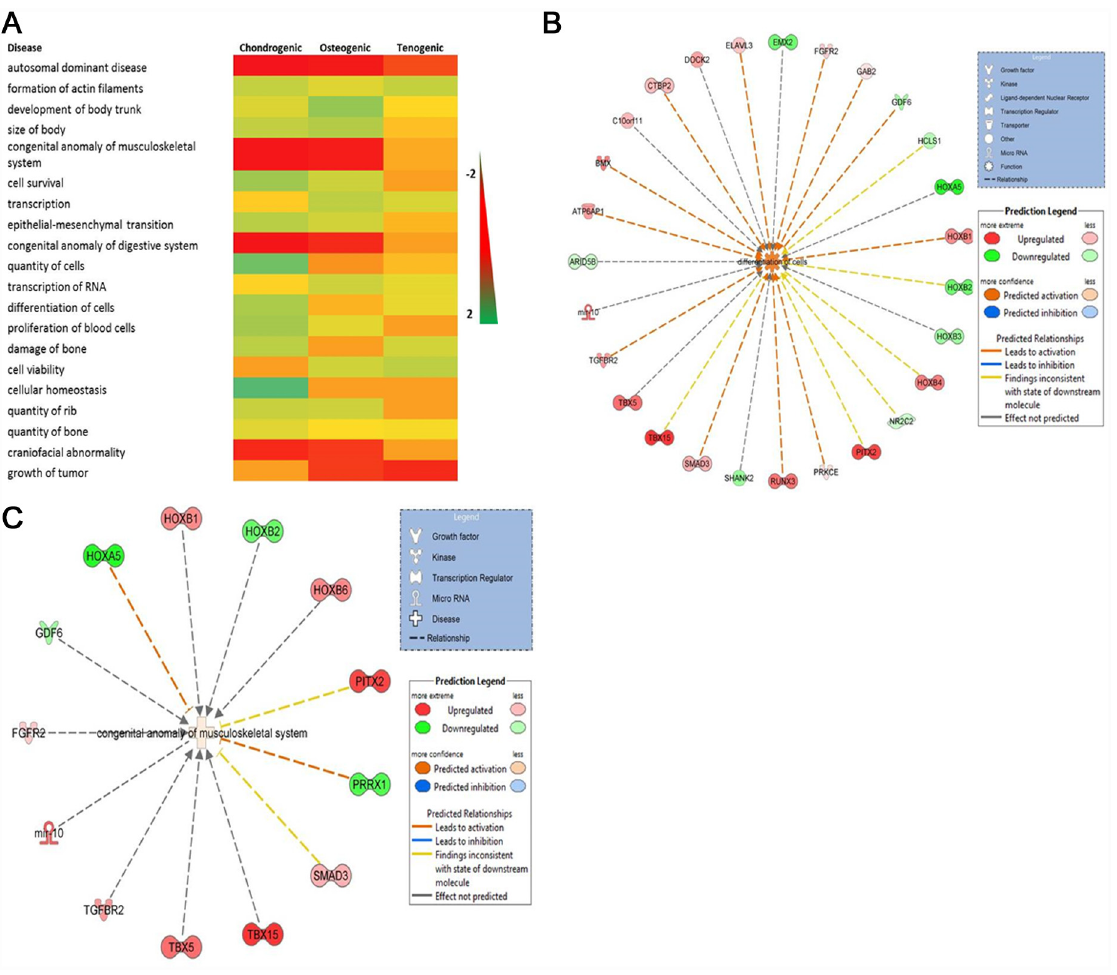
Fig 6. Diseases and biological functions identified from the sets of DM loci input into IPA for chondrogenic, osteogenic and tenogenic engineered tissues. A. Heatmap of the top 20 diseases and biological functions identified using IPA comparison analysis with significant activation z scores (infers the activation state of regulation). Scale relates to activation Z scores were green is a positive activation z-score (activated) and red is a negative score (inhibited). B. A cell differentiation network was identified in all engineered tissue types. The network shown includes DM genes identified in tenogenic tissues. C. The network ‘ congenital anomaly of the musculoskeletal system ’ was activated in tenogenic tissues. In networks red genes relates to those hypomethylated and green hypermethylated in tissues derived from older